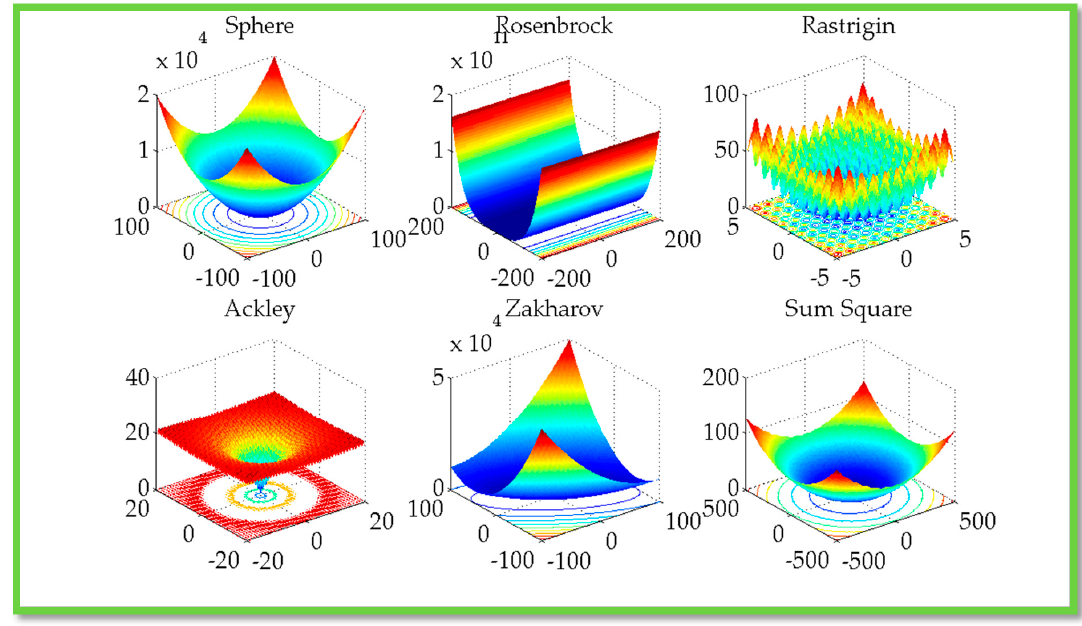
Figure 14. Benchmark mathematical functions.